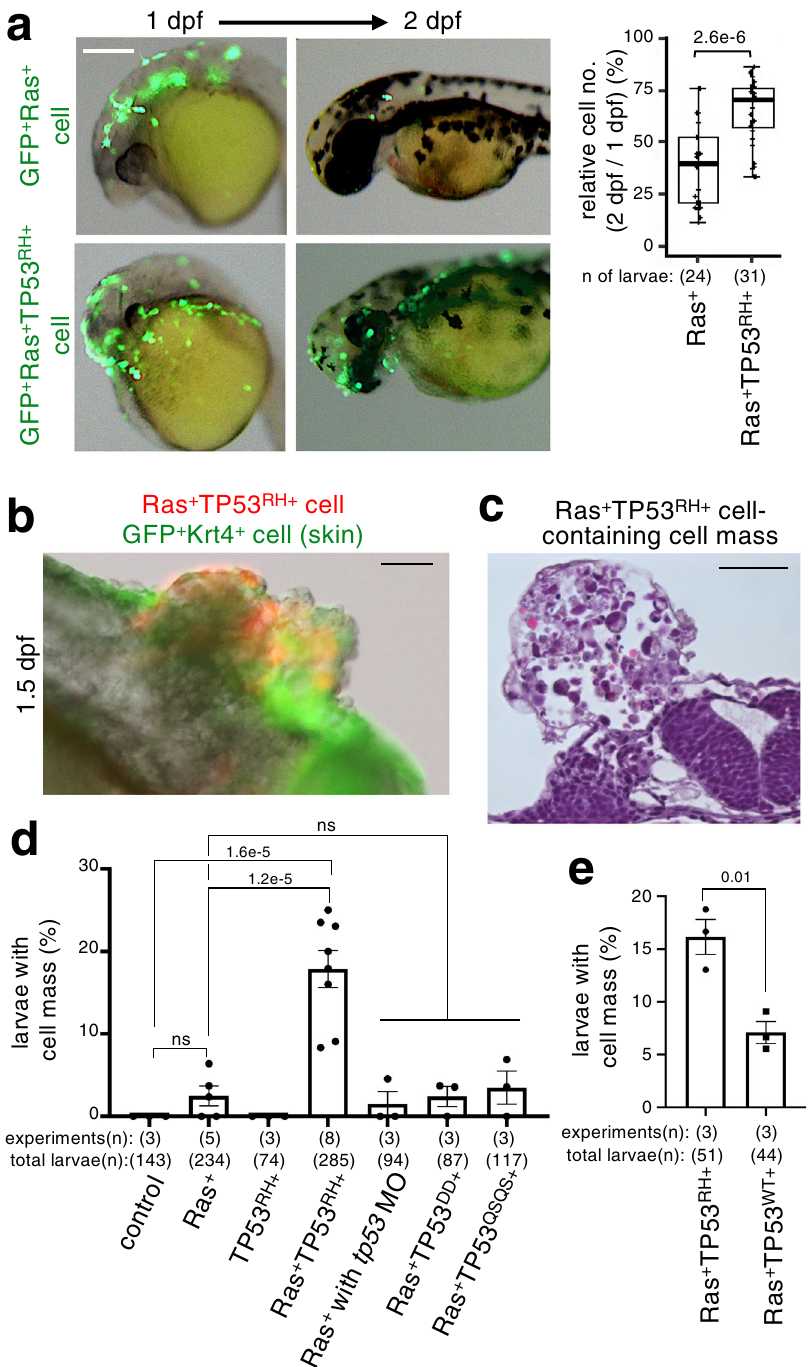
Fig. 3 TP53 R175H mutation attenuates mosaic Ras G12V cell elimination and stimulates heterogeneous cell mass formation. a Mosaic Ras G12V TP53 R175H cells remain in larval skin. Representative images show larvae with mosaically introduced GFP + Ras G12V (GFP + Ras + ) or GFP + Ras G12V TP53 R175H (GFP + Ras + TP53 RH + ) cells (green). Scale bar: 200 μ m. Box plots of relative GFP + cell number of 2 dpf/1 dpf ratio show fi rst and third quartile, median is represented by a line, whiskers indicate the minimum and maximum. Each dot represents one larva. Unpaired two-tailed t -test was used. b – e TP53 gain of function, but not loss of function, stimulates heterogeneous cell mass formation. In b , representative images show cell mass in the trunk region of larvae with mosaically introduced mKO2 + Ras G12V TP53 R175H (Ras + TP53 RH + ) cells (red) at 1.5 dpf. Skin surface layer cells were visualised with krt4p:gal4; UAS:EGFP (green). In c , representative image of haematoxylin and eosin staining of cell mass in the trunk region of larvae with mosaically introduced Ras + TP53 + cells. Scale bar: 50 μ m. Graph in d and e shows the percentage of 1.5 dpf embryos with cell mass (Means ± SEM). Each dot represents an independent experimental result. In d , A two-tailed one-way ANOVA test with Sidak correction was used. In e , Unpaired two-tailed t- test was used. Note that cell mass formation was induced not only in the head region but also in the trunk and tail regions. Source data are provided as a Source Data fi